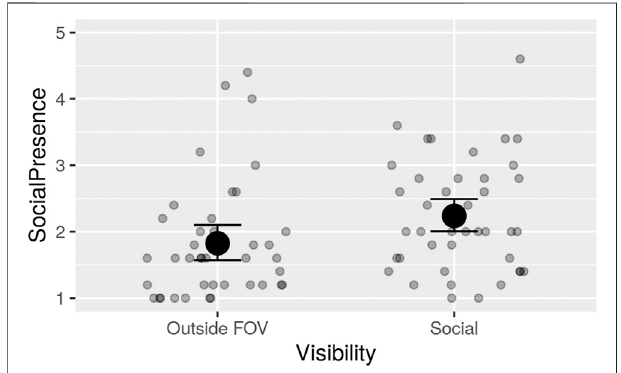
FIGURE 5 | Self-reported social presence was signi fi cantly higher in the Social condition than the Outside FOV condition. Larger points represent means; smaller transparent points represent individual entries. Error bars are 95% con fi dence intervals of the